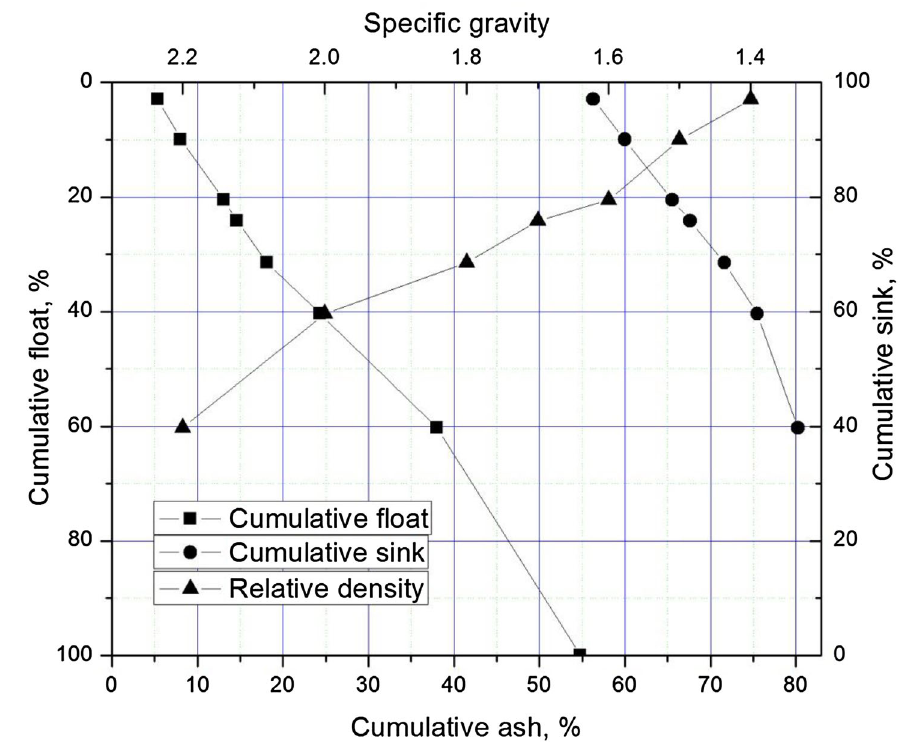
Fig. 4 Washability analysis of feed sample